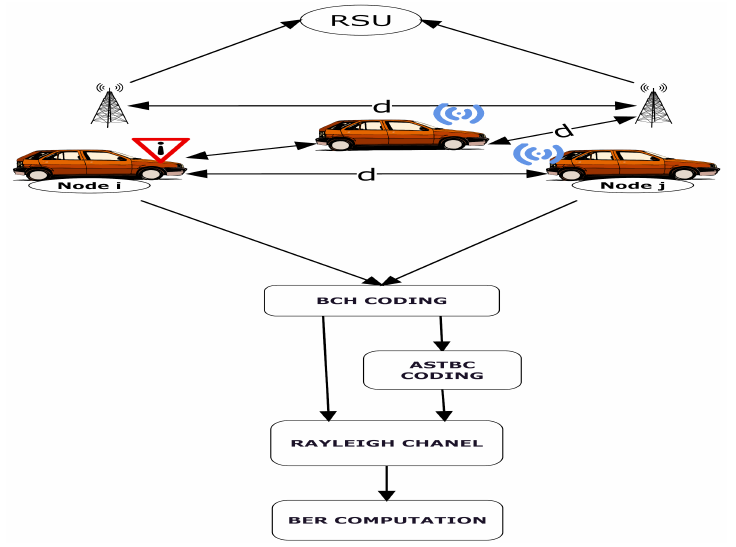
Figure 3. Simulation model. Table 2. Pathloss simulation